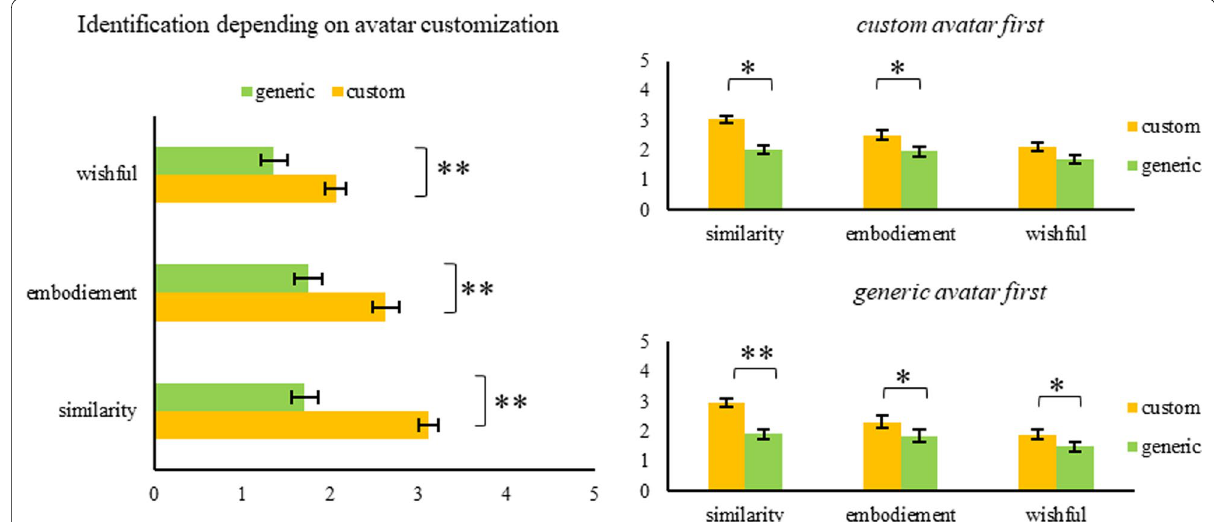
Fig. 3 Player Identification Scale results for all valid participants, split by the order in which the SSG was played (top right: custom avatar first, bottom right: generic avatar first). * p < .05, ** p < .001. Error bars signify the standard error of the